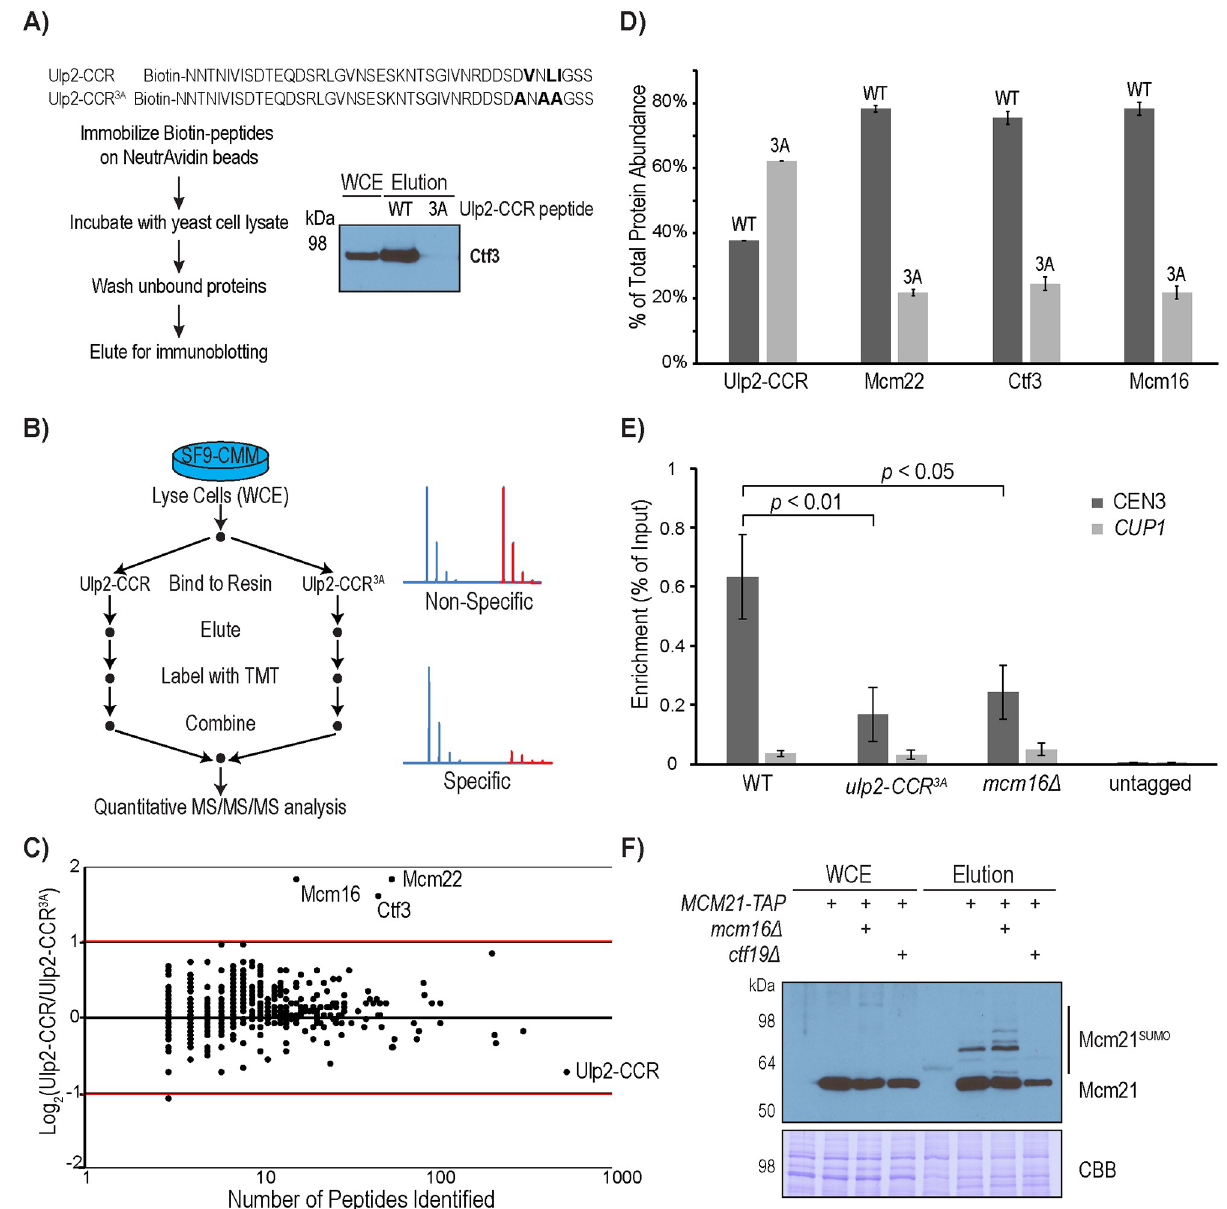
Fig 4. Ulp2’s CCR directly binds to the CMM complex. A) Experimental schematic and Western blot analysis for detecting the binding of a synthetic Ulp2-CCR peptide with Ctf3 in yeast cell extract. B) Experimental design to use TMT-based quantitative MS to compare the binding proteins of Ulp2’s CCR, purified using SF9 cells expressing the CMM complex. C) Log 2 ratios of proteins associating with Ulp2-CCR versus Ulp2-CCR 3A , identified by MS, are plotted on the Y-axis, while the number of peptides identified for each protein is plotted on the X-axis. D) Quantification of the relative abundance of Mcm16, Ctf3, Mcm22 and Ulp2-CCR is shown in Figure 4C. Error bars were calculated based on the standard error of the mean of TMT reporter ions found in multiple peptides of each protein. E) ChIP-qPCR analysis to measure the association of Ulp2 to the Centromere-III revealed a partial role for Ulp2’s CCR and Mcm16. The p -values indicate statistically significant differences of Ulp2-TAF with Ulp2-CCR 3A -TAF and mcm16 Δ using a two-tailed Student’s t-test. F) Effect of mcm16 Δ and ctf19 Δ on sumoylated Mcm21, which was purified using the Ulp1-C580S affinity resin (see Fig 2).